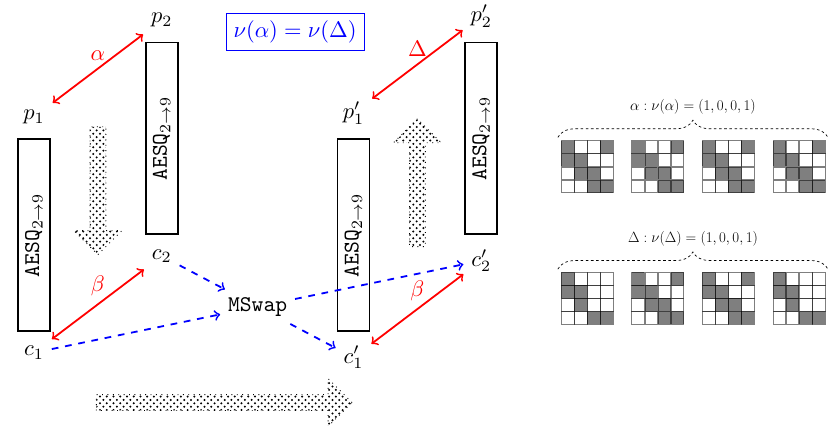
Figure 7: Deterministic 8-round Yoyo distinguisher. ZDP of input difference α is preserved by output difference ∆ of the Yoyo game. A possible configuration of ( α, ∆) is shown. Note that though ν ( α ) = ν (∆) , wt ( ν 2 ( α )) 6 = wt ( ν 2 (∆)). We will use this kind of Nested ZDP to extend the Yoyo beyond 8